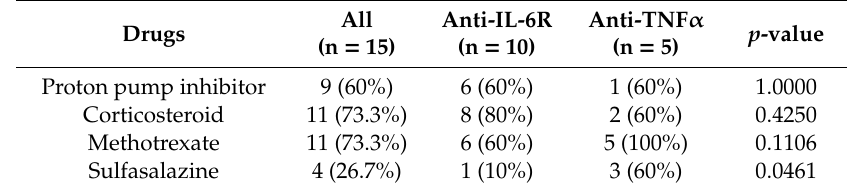
Table 2. Additional drugs used.